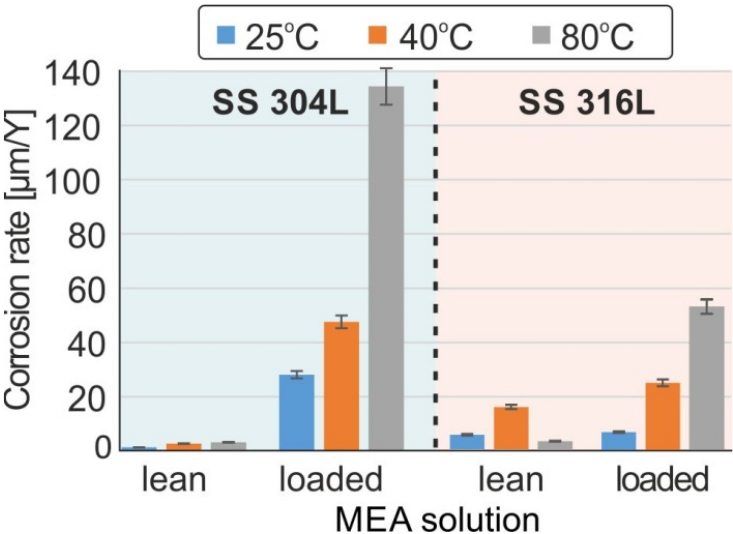
Figure 4. Corrosion rate for SS 304L and SS 316L at 25 °C, 40 °C and 80 °C when immersed in unloaded and loaded MEA solution.